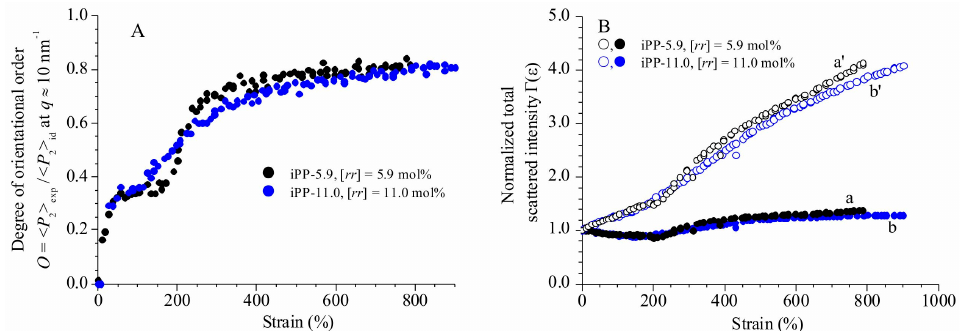
Figure 5. Orientation parameter O ( A ) and total WAXS scattered intensity (invariant) normalized for the integrated intensity of the unoriented sample Γ ( ε ) ( B ) as a function of strain, for the samples iPP-5.9 ( , ) and iPP-11.0 ( , ). The parameter O is calculated from the azimuthal intensity distribution at q ≈ 10 nm − 1 in the bi-dimensional WAXS images of Figure 1, corresponding to the reflection (111) γ of γ form at low deformations, to the tail of the mesomorphic halo centered at q ≈ 11 nm − 1 at high deformations. It represents a measure of the average degree of orientation of the chain axes with respect to the fiber axis at high deformations (> ε end ), and to the average degree of orientation of the residual crystals of γ form in the perpendicular chain axis orientation, and of the transformed mesomorphic domains in the parallel chain axis orientation at deformations lower than ε end . In ( B ), the curves a’ and b’ (open symbols) are obtained by multiplying the curves a and b (full symbols) by the factor t 0 / t = ( l / l 0 ) 1/2 to account for the thickness contraction (see Experimental